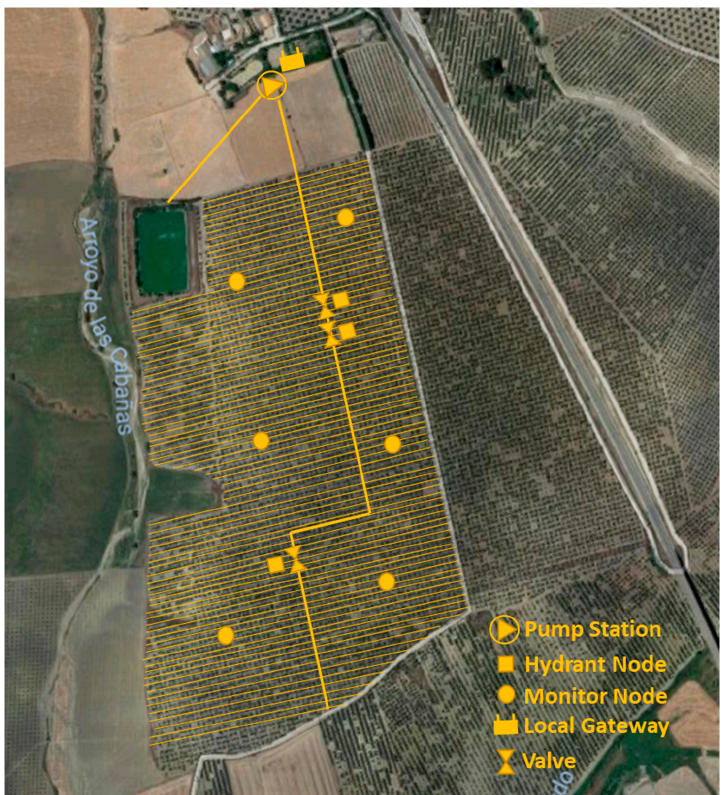
Figure 7. Proposal for node distribution and local gateway distribution. Source: Own elaboration.